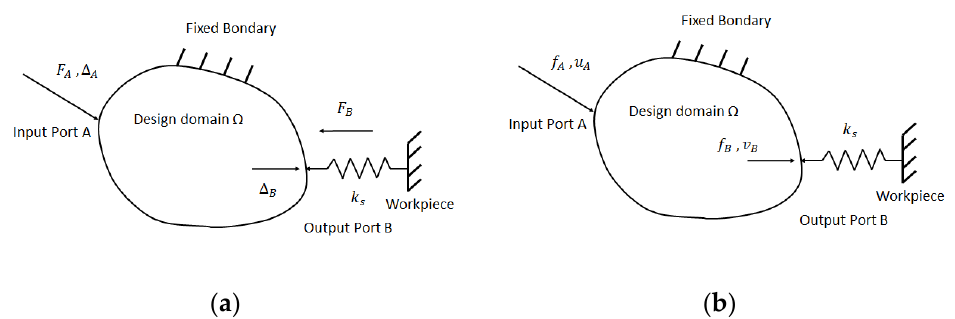
Figure 1. ( a ) Compliant mechanism design; ( b ) mutual potential energy (MPE) calculation.